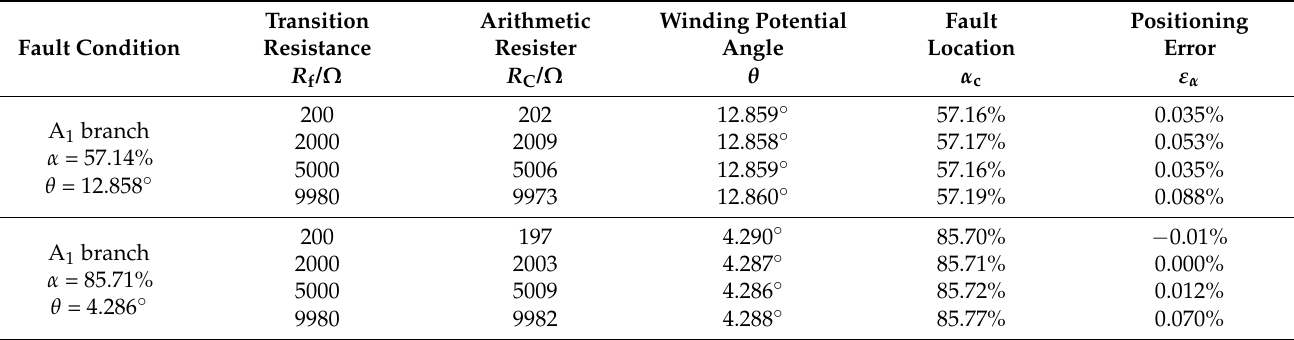
Table 4. The result of fault location.